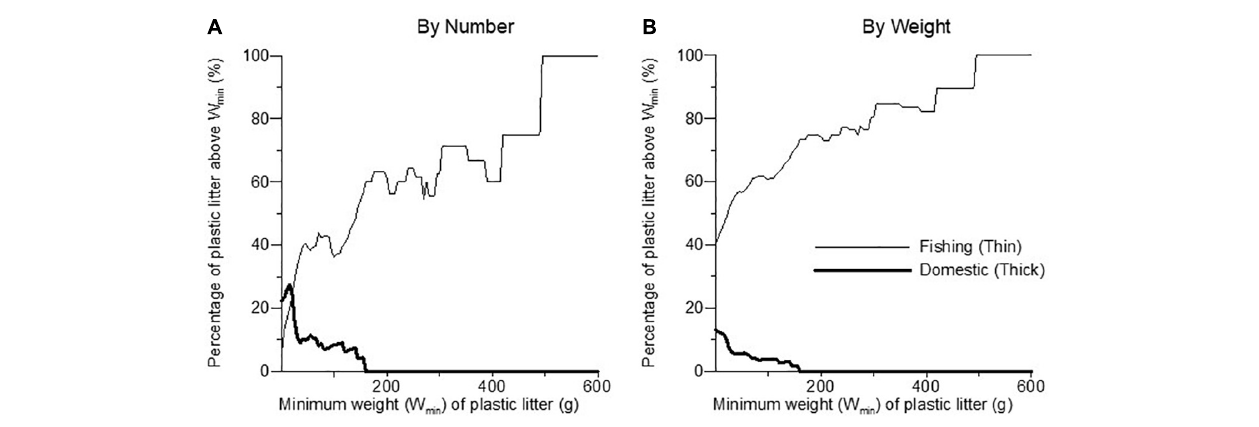
FIGURE 3 | The contribution of plastic beach litter in the “domestic” litter category (thick lines) and in the “fishing” litter category (thin lines). The diagrams show the percentage in each litter category of all plastic litter items which were above a minimum weight ( W min ), (A) by number and (B) by weight. More details in text.